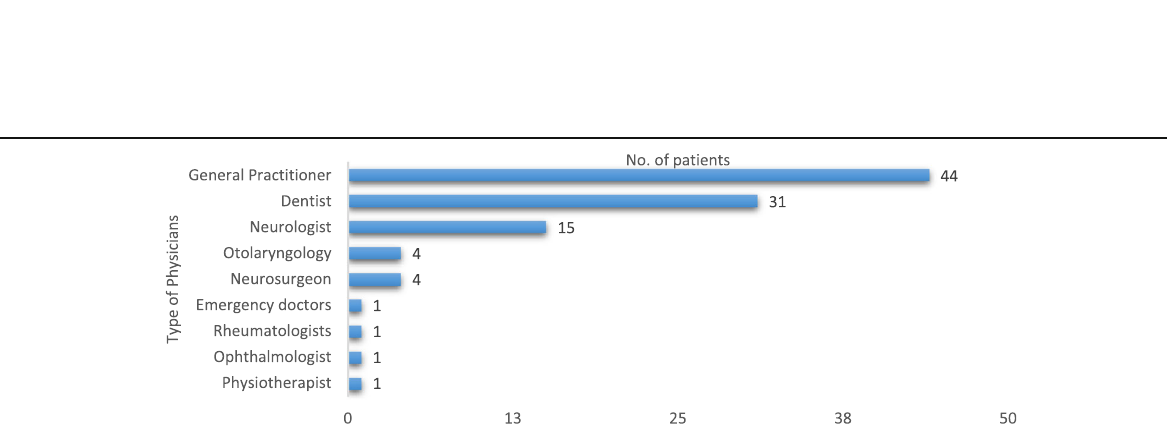
Fig. 2 Physicians consulted by the patients before being correctly diagnosed as suffering from